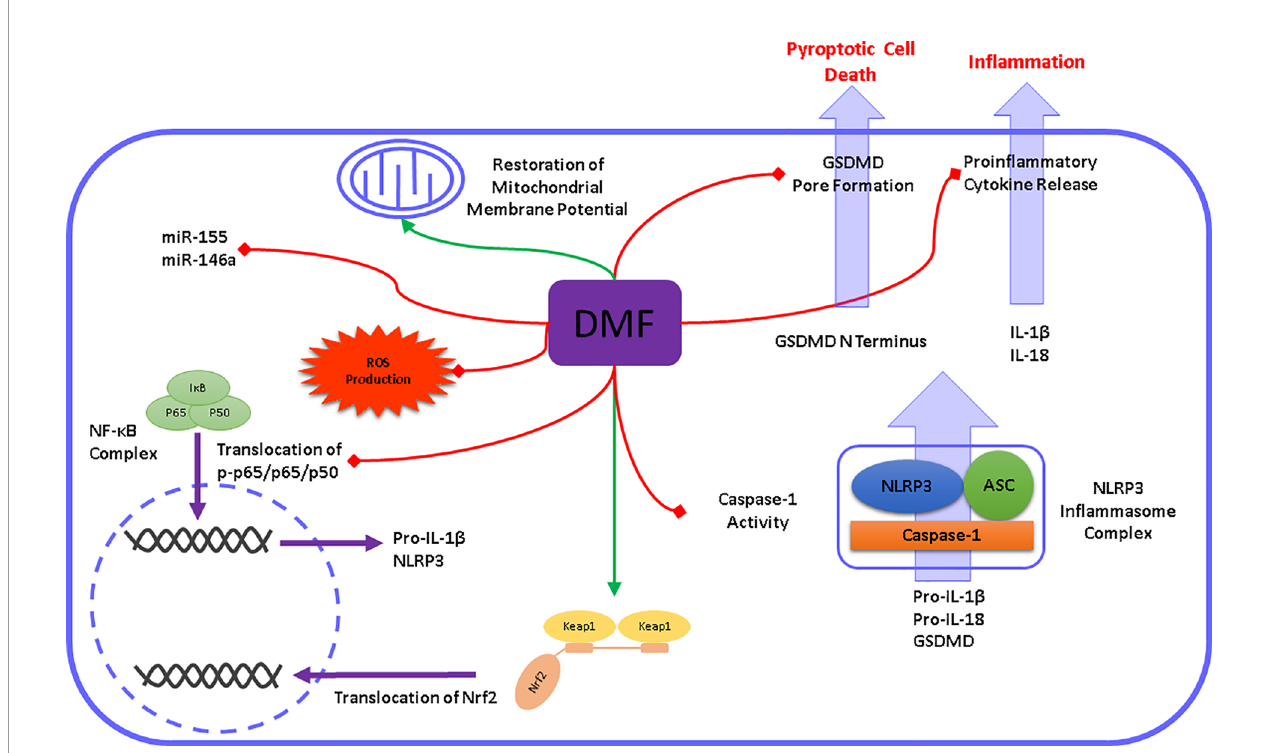
FIGURE 8 | Schematic illustration of DMF modulating microglial NLRP3 in fl ammasome activation. DMF modulates the NLRP3 in fl ammasome signaling pathway at different levels. In the priming step, DMF prevents the translocation of NF- k B and subsequently downregulates the expression of NLRP3, IL-1 b , and IL-18. Additionally, DMF promotes Nrf2 activation and upregulates the expression of Nrf2 target genes. Accordingly, DMF reduced the formation of cellular and mitochondrial ROS and restored the mitochondrial membrane potential. In the activation step, DMF inhibits caspase-1 cleavage and its activity. Subsequent cleavage of pro-in fl ammatory cytokines and pore-forming GSDMD was prevented by